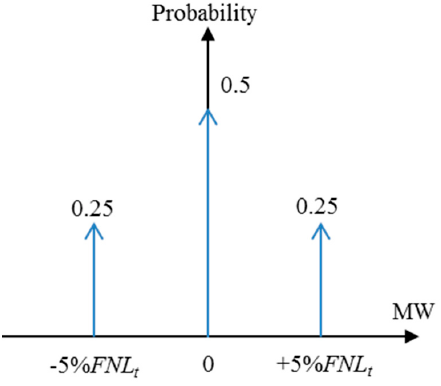
Figure 1. Triangular distribution for the example.